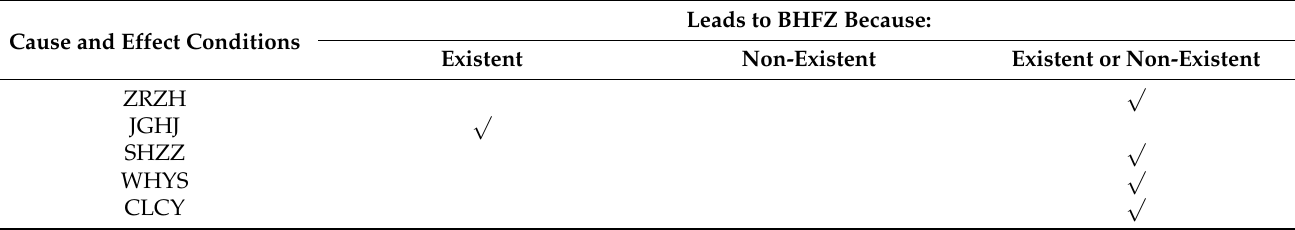
Table 11. Directionality preset of intermediate